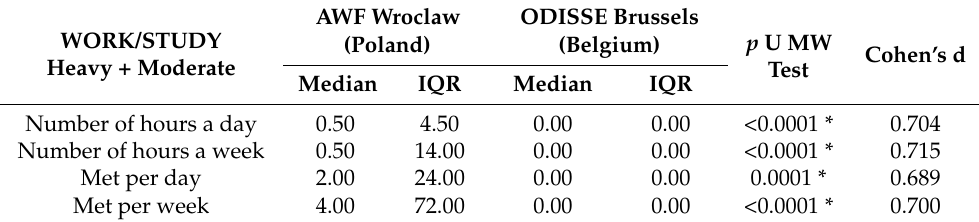
Table 7. Physical activity related to traveling from place to place (GPAQ).